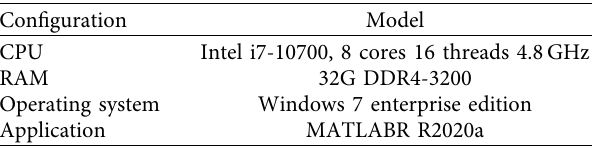
Table 2: Experimental environment